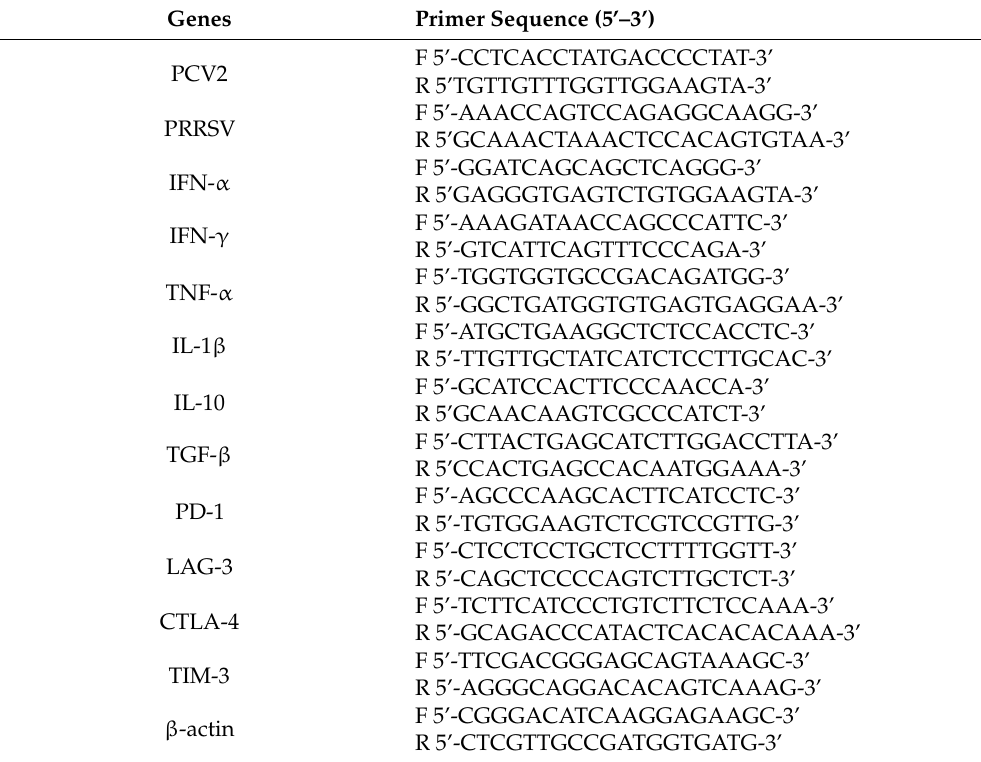
Table 2. Primer sequences of the reference